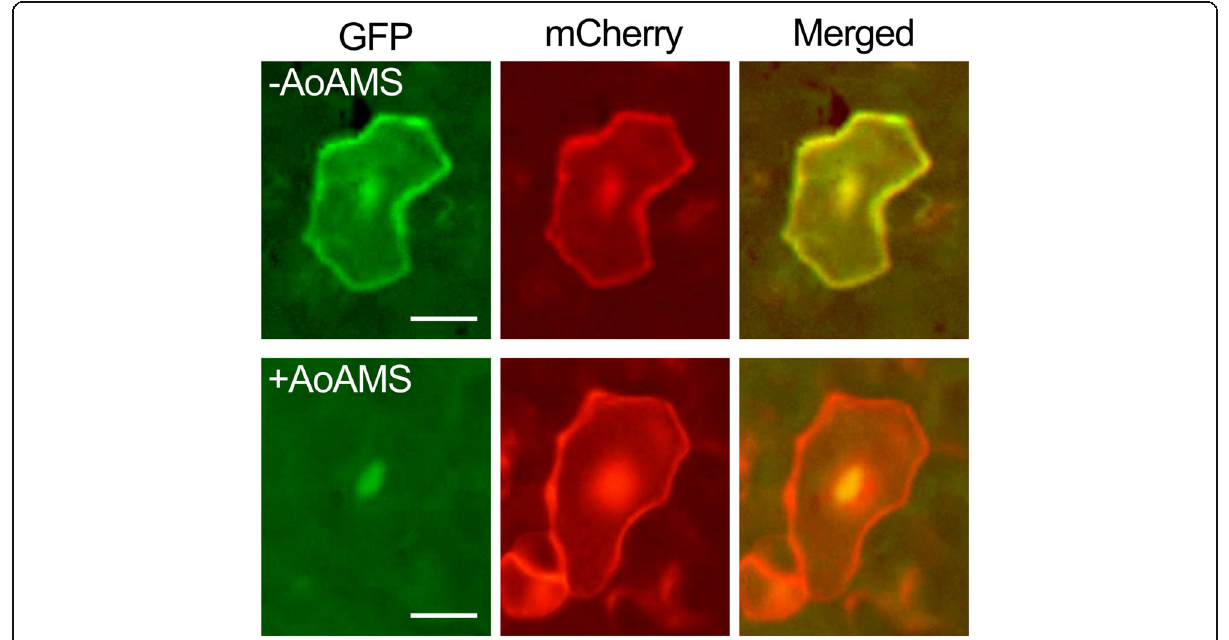
Fig. 3 Co-transfer of two exogenous genes into Chinese cabbage leaf cells via TSGAMAP. Either a construct with GFP ( “ -AoAMS ” , top panels) or a construct with the AoAMS-GFP chimeric gene ( “ +AoAMS ” , bottom) was shot with a construct with mCherry. Scale bars = 25 μ